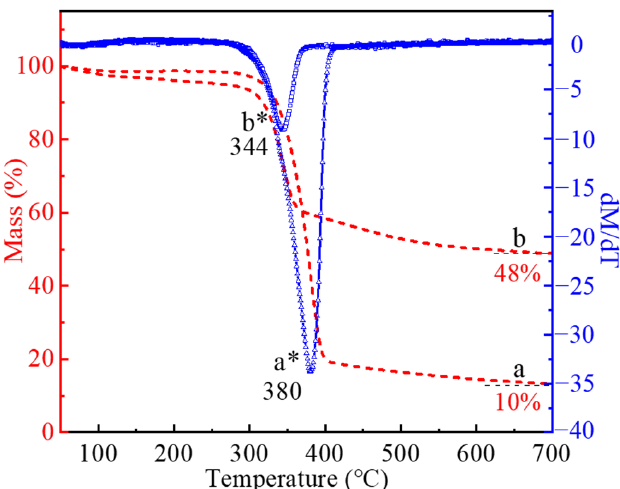
Figure 7. TG and DTG spectrum of fabrics. The TG of original fabric ( a ) and finished fabric ( b ), and the DTG of original fabric ( a* ) and finished fabric ( b* ). Table 3. TG parameters of cotton fabric